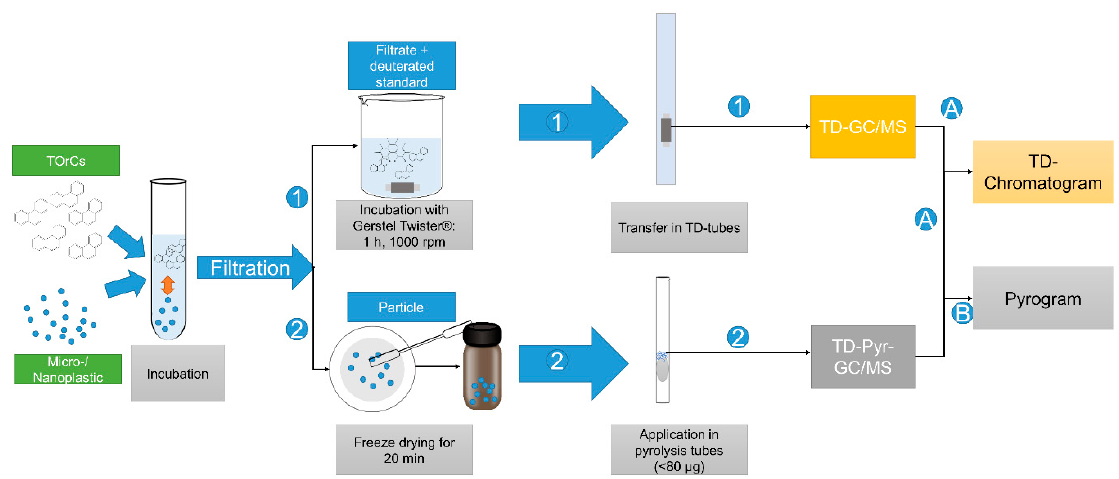
Figure 1. First, the TOrCs and microplastic particles are incubated in aqueous solution. Then, the sample is filtered. The filtrate (1) is mixed with the deuterated standard and stirred for 1 h with the Twister. The Twister is added to the TD tube and analyzed via TD-GC/MS. The TOrCs are analyzed via the TD chromatogram ( A ). The particles (2) are scraped off the filter with a spatula, placed in a vial, and freeze dried. The dried particles are weighed directly into the pyrolysis tube and analyzed by TD-Pyr-GC/MS. The TD chromatogram is used to evaluate the volatiles ( A ), and the pyrogram is used for the polymers ( B